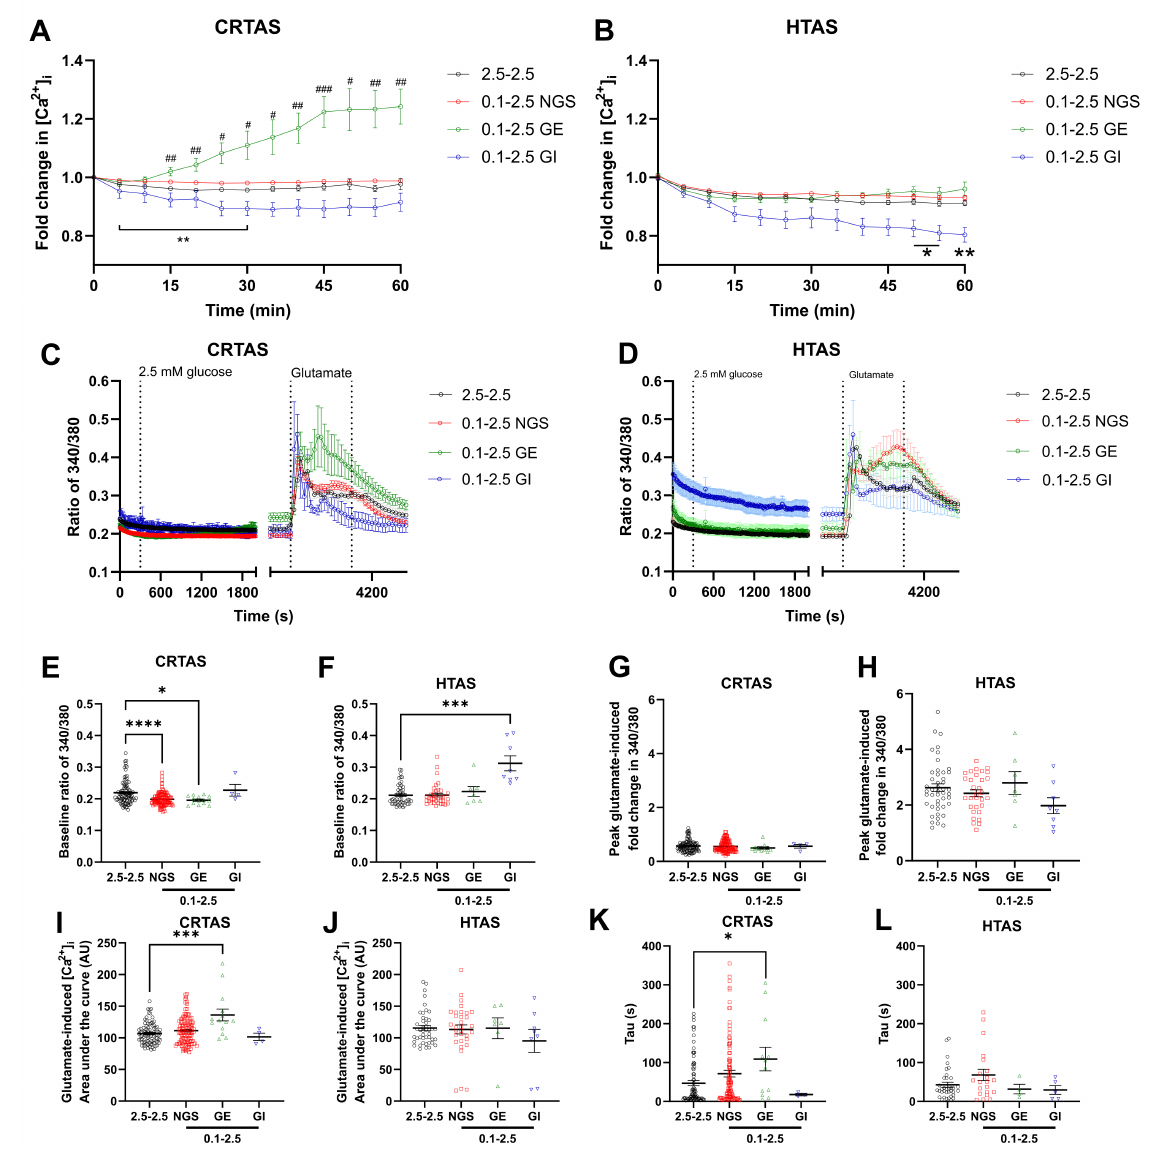
Figure 3. Reversal of low glucose-induced calcium response by return to normal glucose. Primary cortical (CRTAS) and hypothalamic (HTAS) astrocytes were loaded with Fura-2 calcium sensitive dye for 1 h in either 2.5 mmol/L glucose (CRTAS n = 98 cells across 6 coverslips; HTAS n = 48 across 5 coverslips) or 0.1 mmol/L glucose (CRTAS n = 137 cells across 7 coverslips; HTAS n =